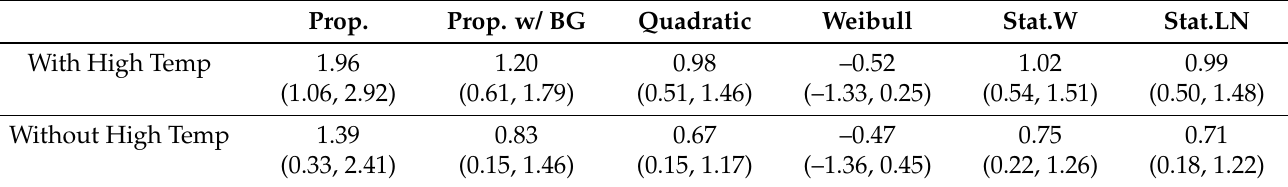
Table 5. Posterior means and 95% confidence intervals of total mortality reduction per 1000 Deaths (1998–2000): without high temperature